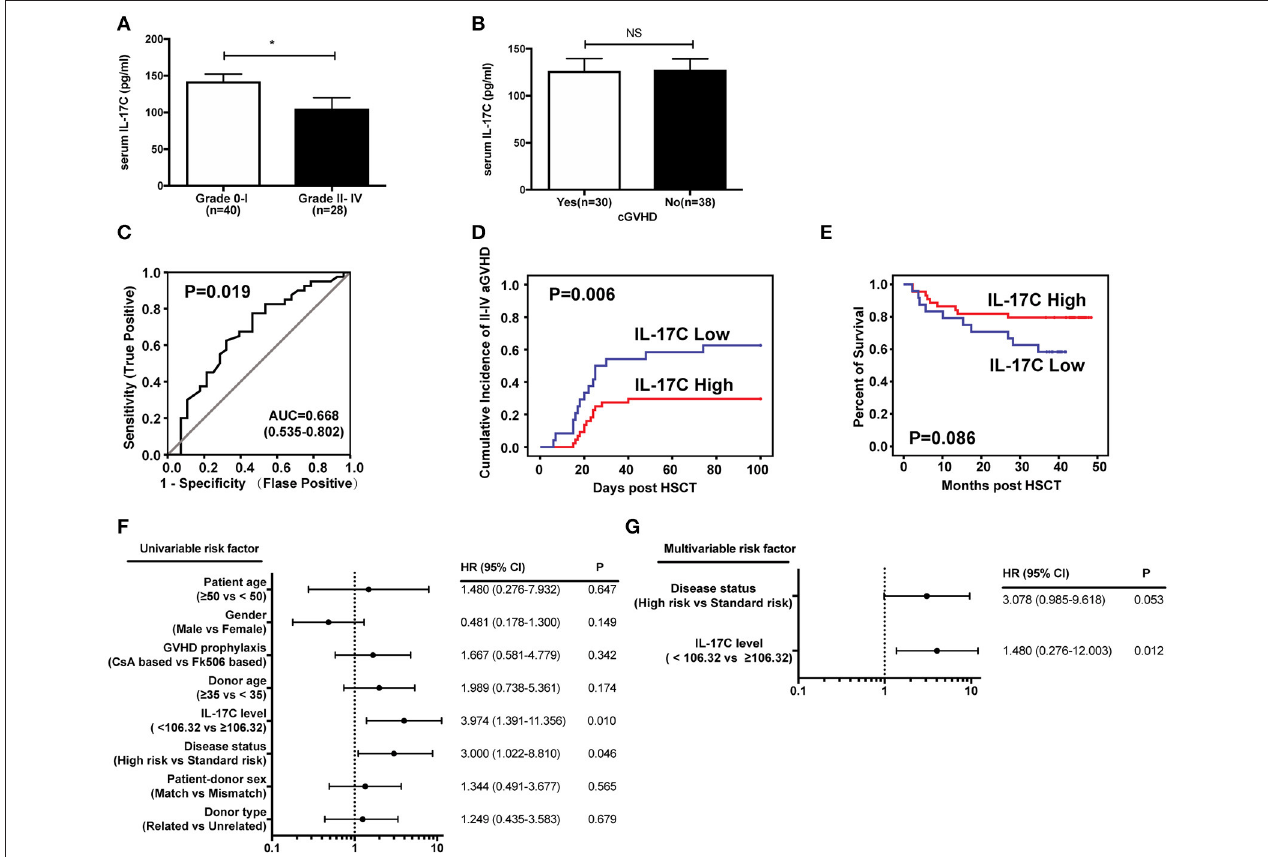
FIGURE 7 | IL-17C expression level predicts aGVHD incidence and severity in allo-HSCT patients. Expressions of IL-17C in human allo-HSCT patients during pre-conditioning were measured by ELISA. ( A ) IL-17C expression in aGVHD patients. ( B ) IL-17C expression in cGVHD patients. ( C ) Sensitivity and specificity of the analysis. The area under the ROC curve (AUC) was 0.668. The cutoff value used from the ROC curve was 106.32 pg/ml. Sensitivity and specificity was 77.5 and 53.6%, respectively. ( D ) The cumulative incidence of grade II-IV aGVHD was significantly lower in patients with high IL-17C expression levels by using Gray’s test. ( E ) IL-17C-high patients showed prolonged survival compared to those with low IL-17C expression with Kaplan-Meier survival by log-rank test. ( F ) Univariate analyses revealed that IL-17C levels < 106.32 pg/ml were significantly associated with grade II-IV aGVHD. ( G ) Fine and Gray proportional hazards model analysis confirmed that low IL-17C level was the strongest parameter associated with II-IV aGVHD. * P <